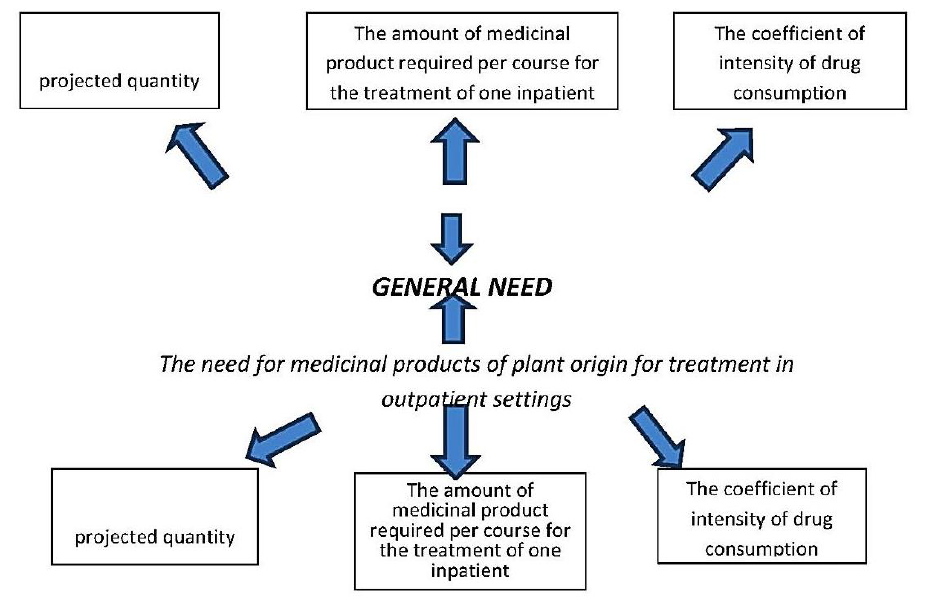
Fig. 1.An algorithm for predicting the need for medicinal products of plant